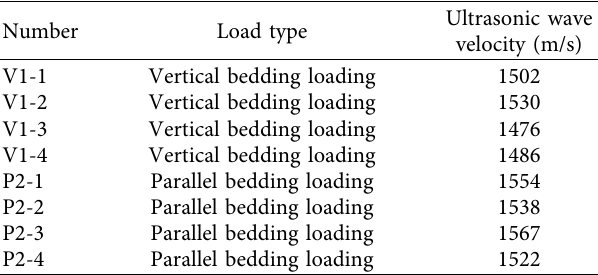
Figure 1: Test system. Table 1: Ultrasonic velocity measurement of raw coal